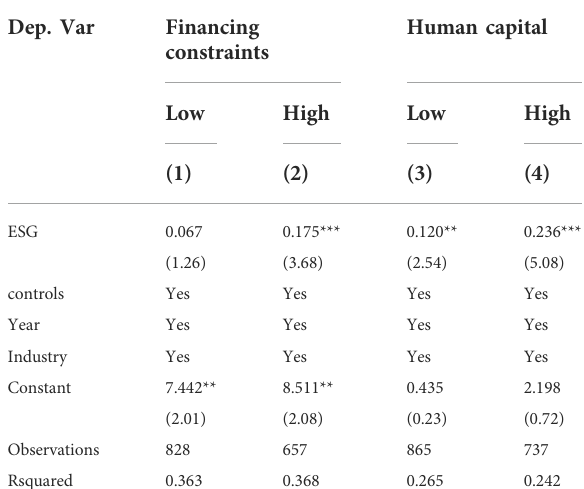
TABLE 7 Impact mechanism